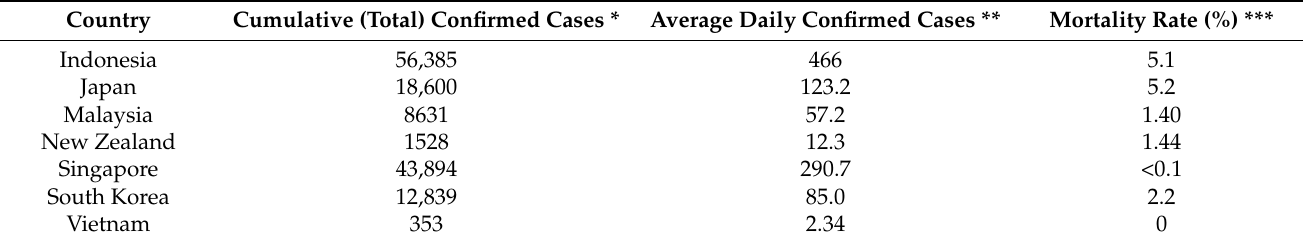
Table 1. Data of cumulative cases, average daily cases, and the mortality rate from 1 February to 30 June 2020.